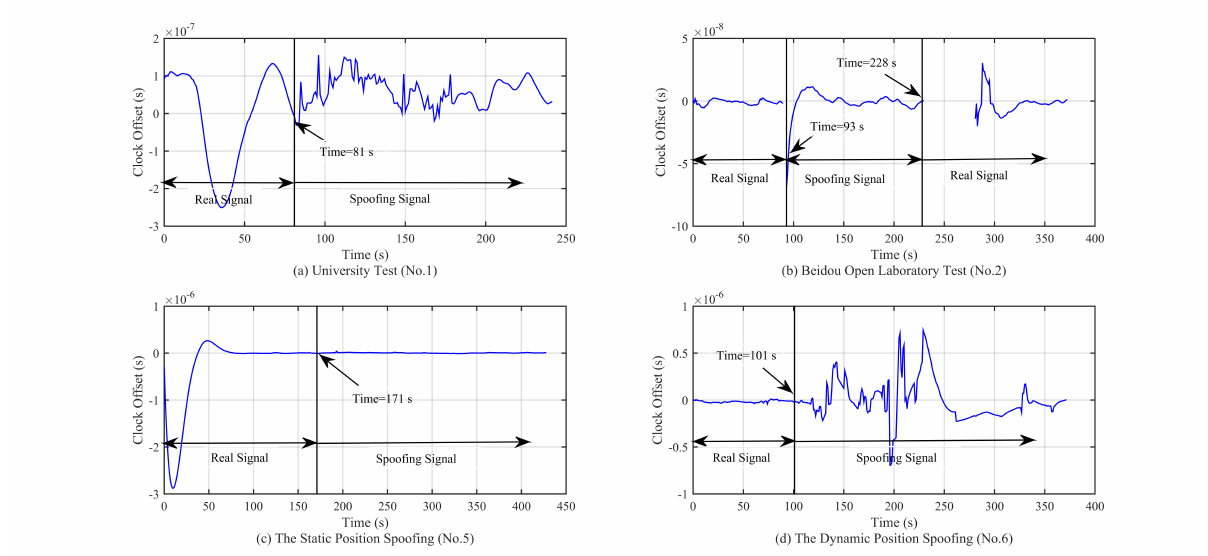
Figure 12. Curve of the clock offset in different experimental